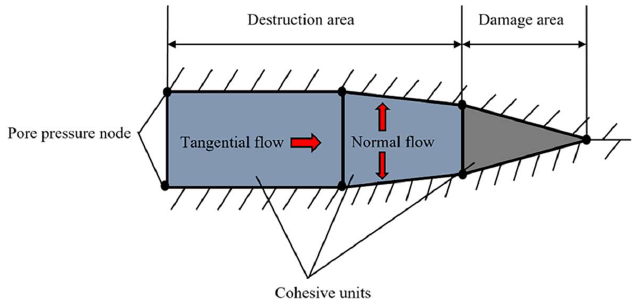
Figure 1. The fluid flow schematic within a damaged unit.